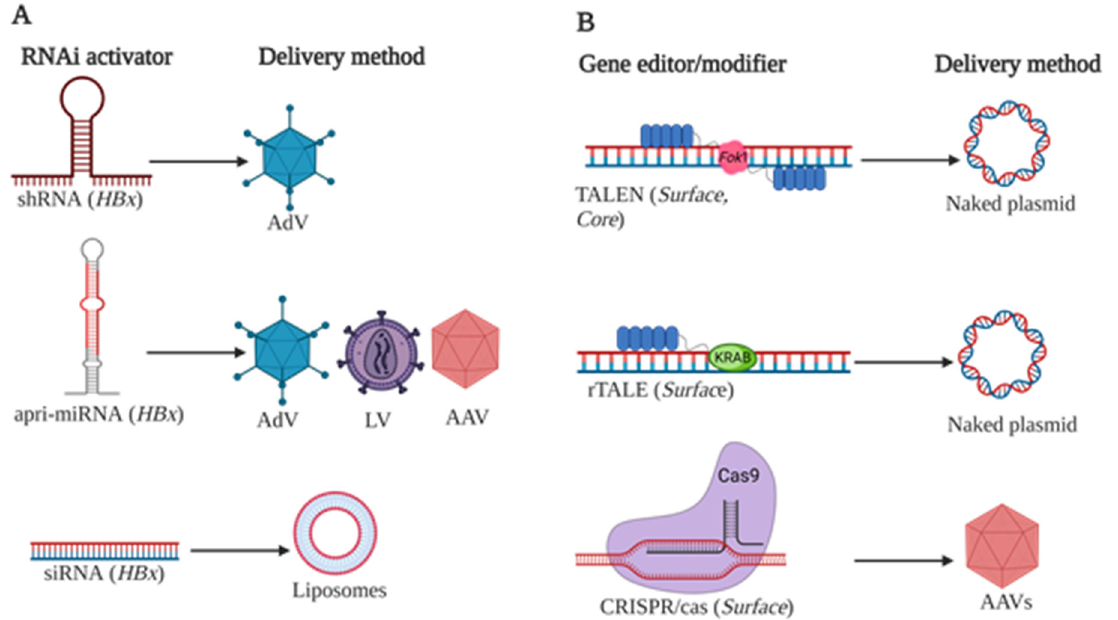
Figure 1. Gene therapy tools used for targeted disruption of HBV replication in South Africa. ( A ) RNAi activators such as short hairpin RNAs (shRNAs), artificial primary microRNAs (apri-miRNAs), and short interfering RNAs (siRNAs) targeting hepatitis B x ( HBx) sequence were designed and delivered using adenoviral vectors (AdVs), AdVs/lentiviral vectors (LVs)/adeno-associated viral vectors (AAVs) and liposomes, respectively. ( B ) Transcription activator-like effector endonucleases (TALENS) targeting Core or Surface and Transcription activator-like repressors (rTALEs) targeting Surface were generated and delivered as naked plasmid DNA. Clustered Regularly Interspaced Short Palindromic Repeats (CRISPR) with CRISPR-associated (Cas) RNA-guided nucleases (CRISPR/c as) targeting Surface were designed and delivered using AAVs (Created with biorender.com).